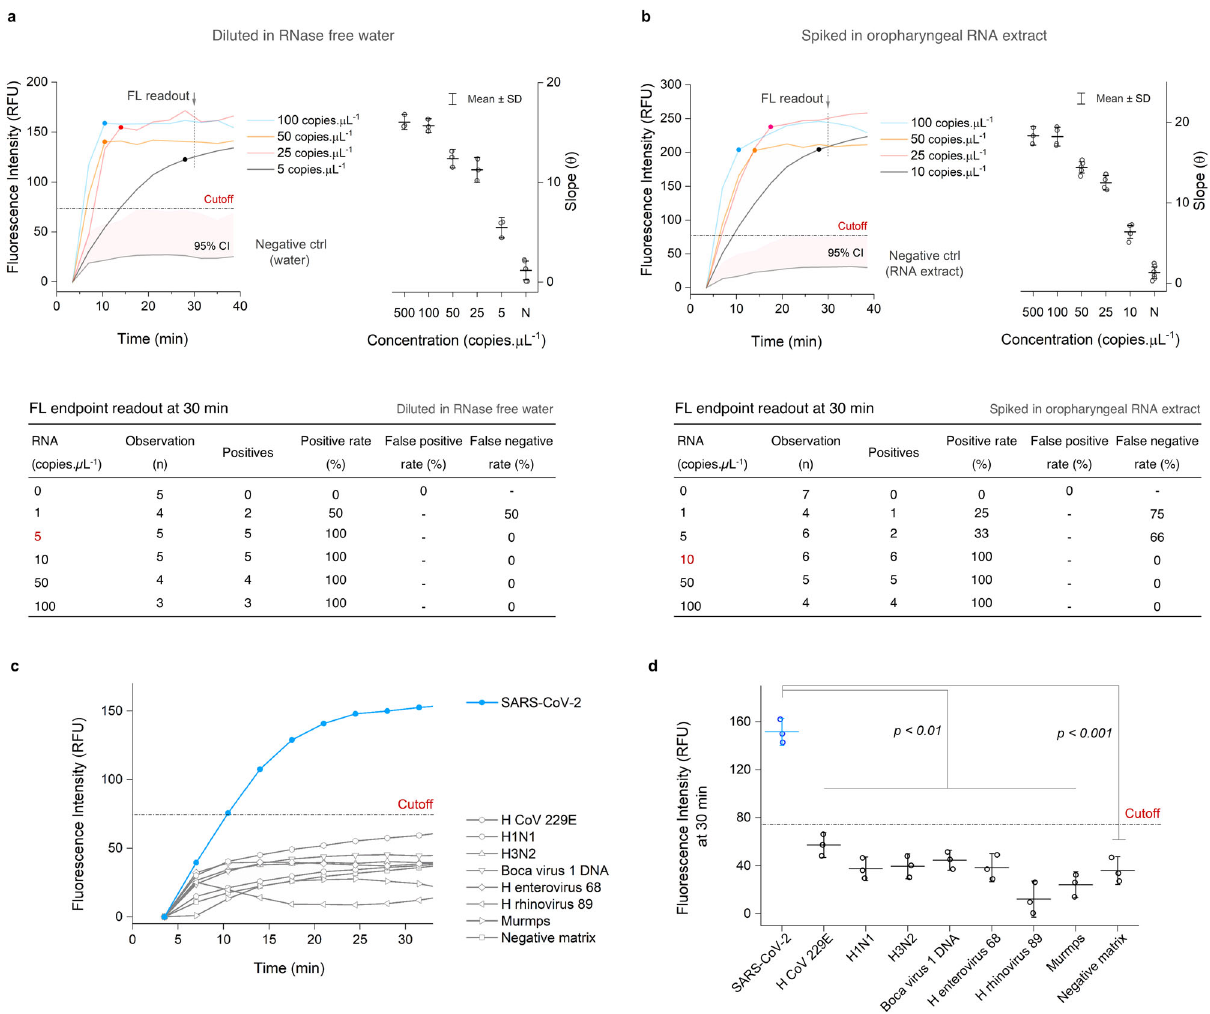
Fig. 5 NISDA assay performance. a Assay response to different dilutions of synthetic SARS-CoV-2 RNA from 100 copies µ L − 1 to 5 copies µ L − 1 (blue line: 100; yellow line: 50; red line: 25 and black line: 5) in nucleases free water. b Assay response to different dilutions of synthetic SARS-CoV-2 RNA from 100 copies µ L − 1 to 10 copies µ L − 1 (blue line: 100; yellow line: 50; red line: 25 and black line: 10) in oropharyngeal RNA extract, together with their corresponding quanti fi cation graphs and dataset based on the calculated signal enhancement slope ( Ɵ ) and fl uorescence readout at 30 min of reaction, respectively. FL, CI, N, and SD denote for fl uorescence, con fi dence interval, negative control, and standard deviation, respectively. c Typical fl uorescence kinetics recorded over time for SARS-CoV-2 RNA (10 copies µ L − 1 ) and different respiratory viral nucleic acids (500 copies µ L − 1 ) spiked in validated CoV-19-negative oropharyngeal RNA extract matrix (Hvidovre Hospital). d Corresponding plot of panel c demonstrating the recorded fl uorescence intensities after 30 min of reaction for the studied respiratory viral nucleic acids. Three independent experiments were run ( n = 3) and the P values were calculated based on the unpaired two-tailed t test ( p < 0.01 for SARS-CoV-2 vs. non-targets; P < 0.001 for SARS-CoV-2 vs. negative matrix). Error bars represent mean value (center line) ± SD. copies µ L − 1 is the numbers of RNA strands per µ L (one copy µ L − 1 corresponds to fi ve RNA copies per reaction). Source data are provided as a source data fi